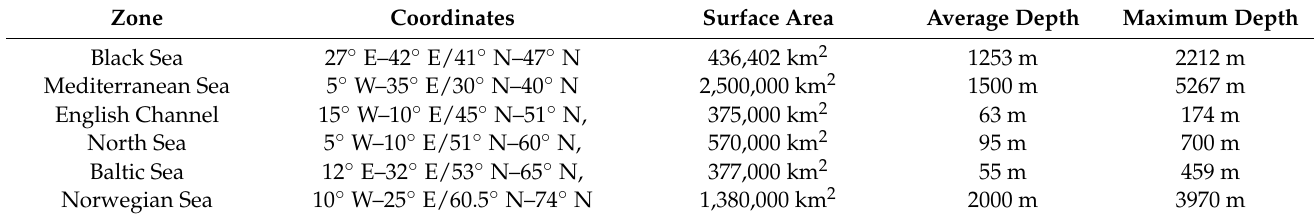
Table 2. Main characteristics of the geographical zones considered in this